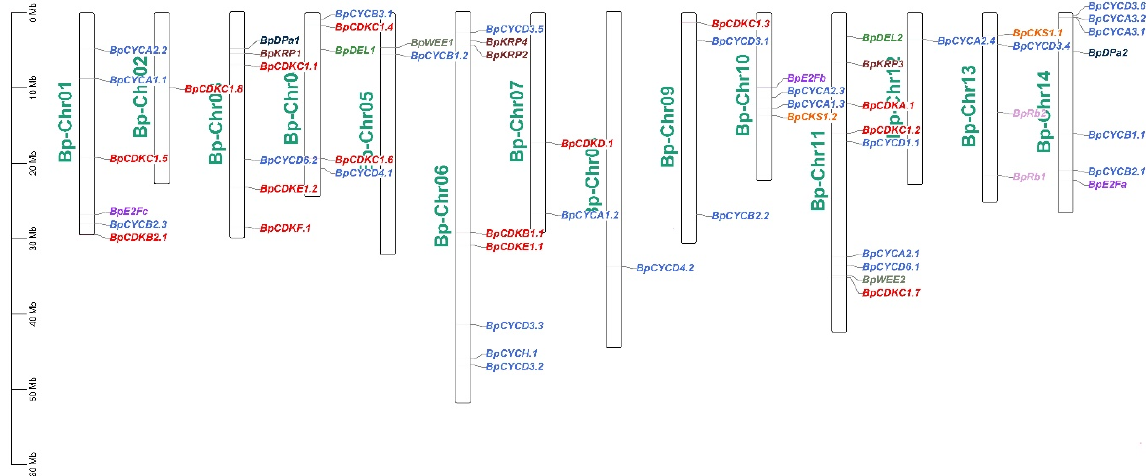
Figure 1. Chromosome distribution of B. pendula cell cycle genes members in birch.